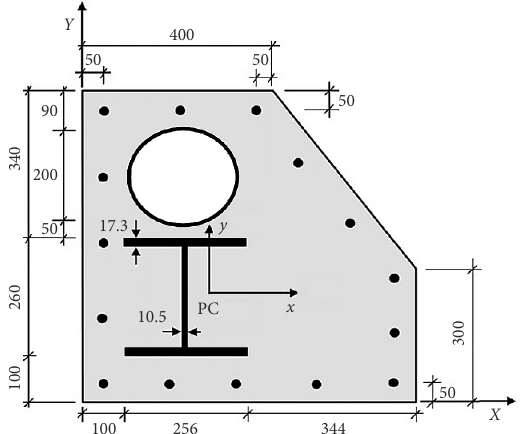
Fig. 7. Composite steel-concrete